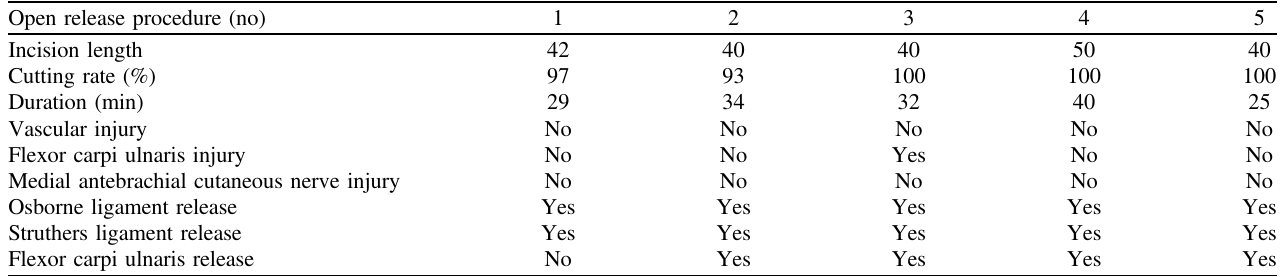
Table 2. Open release procedure